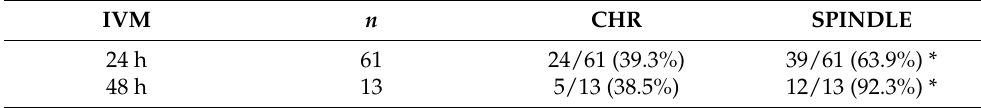
Table 2. Normal spindle configuration and chromosomal position of oocytes depending on the in